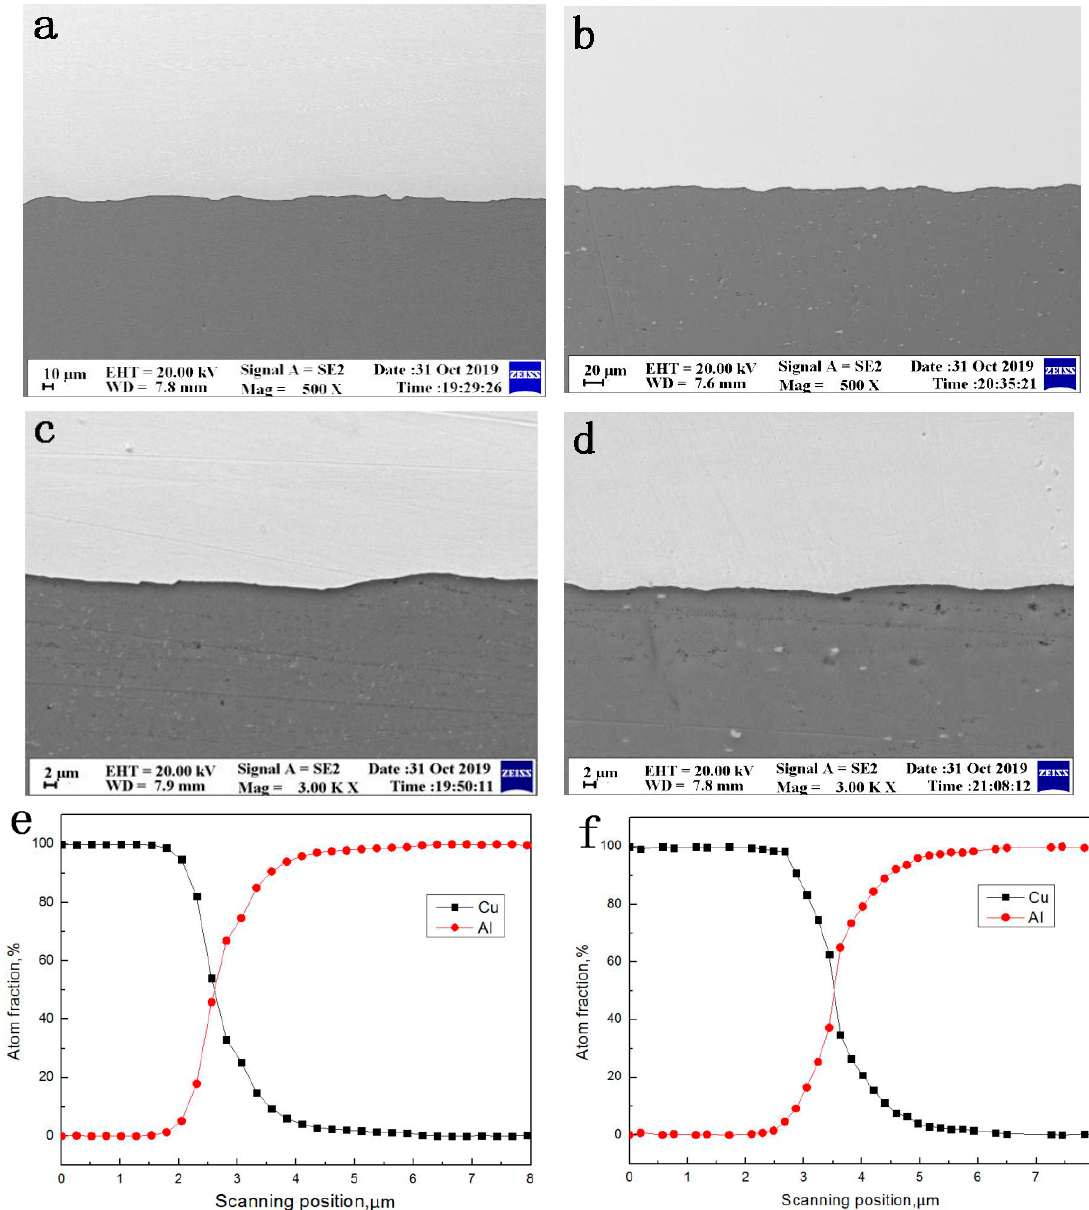
Figure 8. SEM image and diffusion image of the element at the bonding interface: ( a ) 500× unpulsed; ( b ) 500× pulse; ( c ) 3000× unpulsed; ( d ) 3000× pulse; ( e ) unpulsed interface element diffusion; ( f ) pulse interface element diffusion.